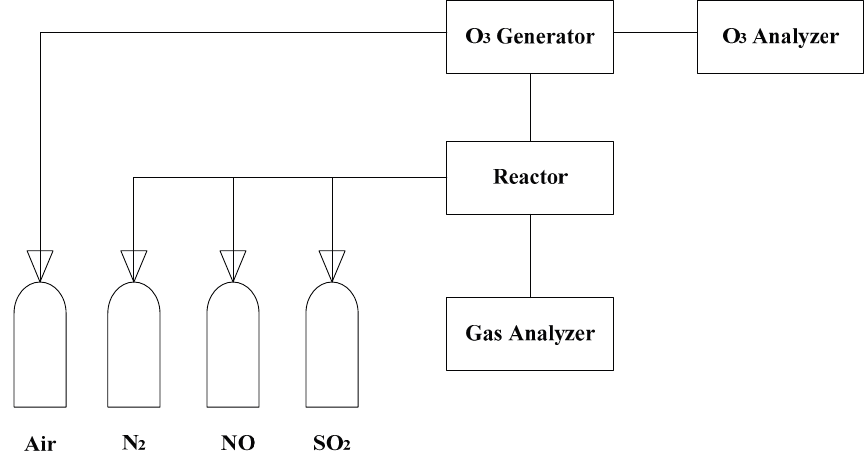
Figure 1. Schematic diagram of the experimental apparatus